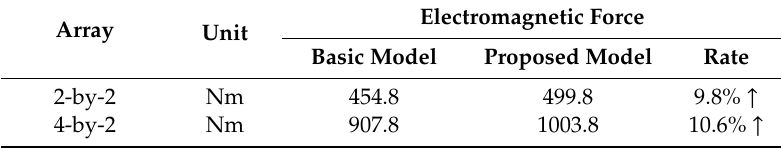
( b ) Figure 20. Prototype of the proposed model: ( a ) upper view; ( b ) bottom view. 270